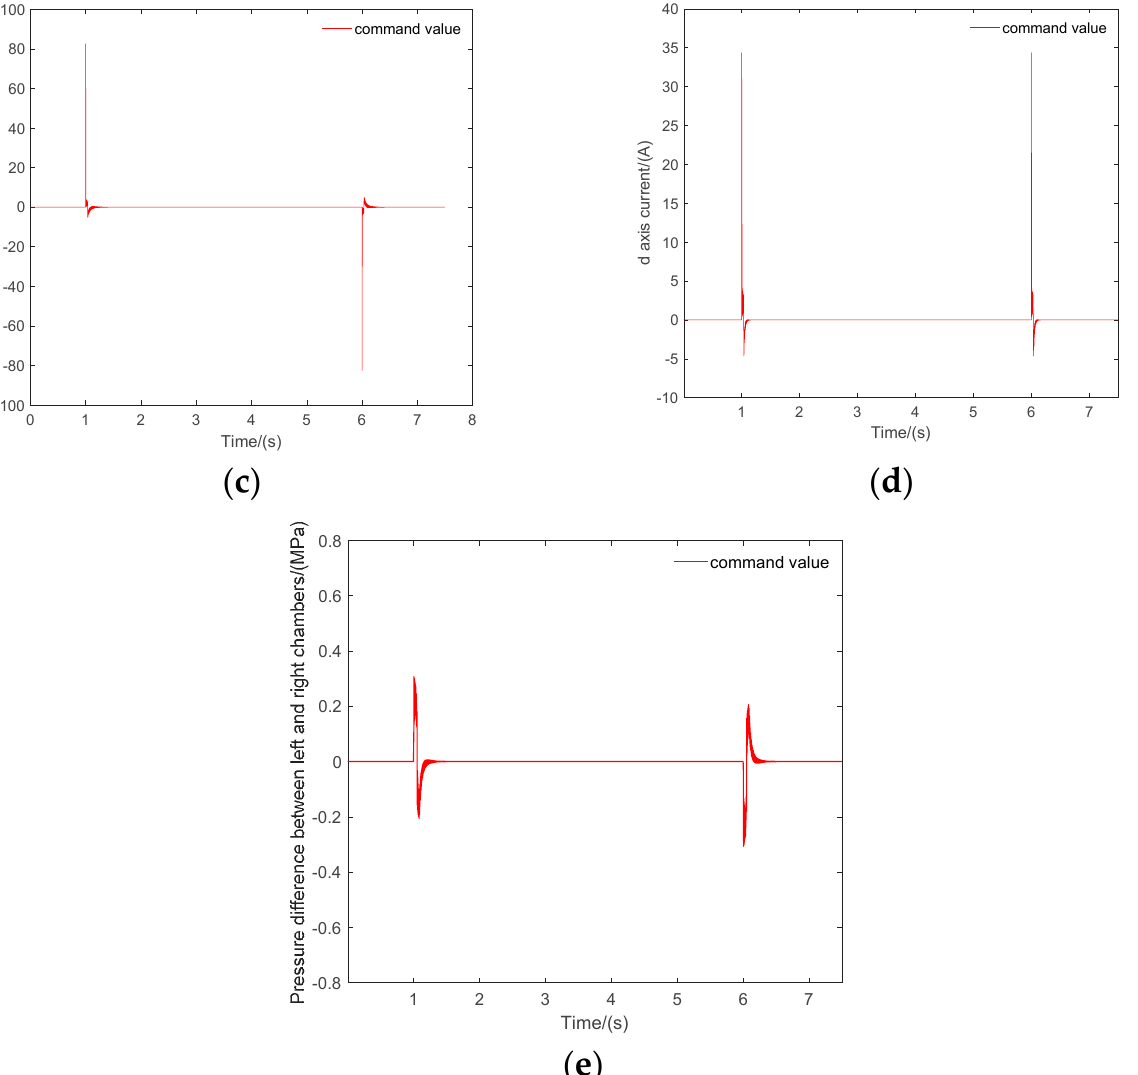
Figure 7. MATLAB/Simulink simulation diagram under 10-degree step signal. ( a ) Angle comparison; ( b ) Motor speed comparison; ( c ) q axis current; ( d ) d axis current; ( e ) Pressure difference between the left and right chambers of the hydraulic cylinder.